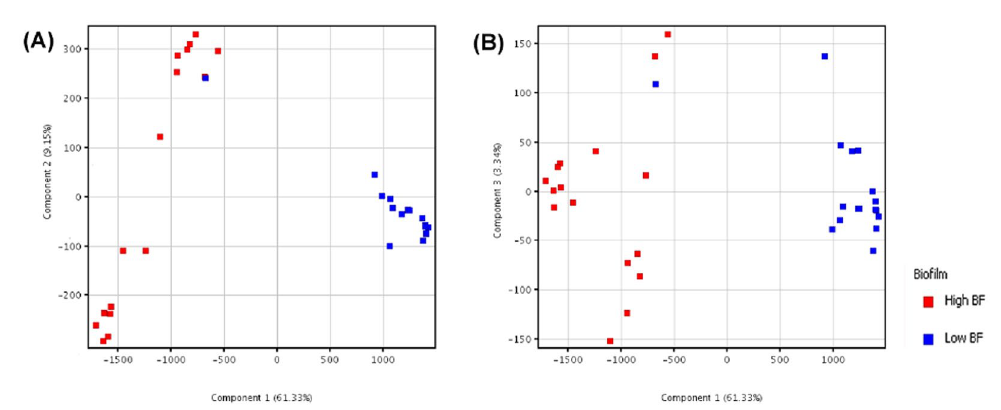
Figure 2. Two-dimensional principal component analysis (PCA) based on 351 significantly different metabolites. The PCAs were generated using MPP. Legend: red (high biofilm-formers, N = 28) and blue (low biofilm-formers, N = 28). Independent replicates are available for Day 1 to 3 samples. Axes represent the first three principle components of the PCA and the numbers indicate the percentage of variance that is captured by each component. ( A ) Shows the H. pylori strains separated based on components 1 (61.33%) and 2 (9.15%), while ( B ) shows the strains separated based components 1 (61.33%) and 3